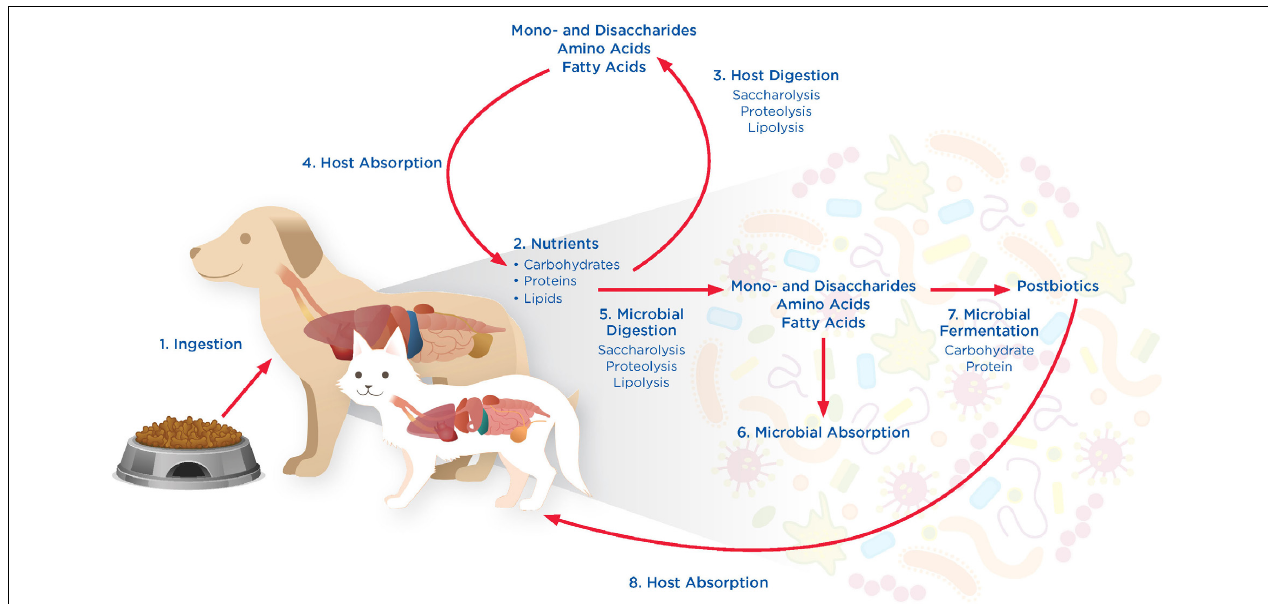
FIGURE 1 | Tripartite interactions between pet foods, the GI microbiome, and host in 8 phases. (1) Ingestion: Dogs and cats ingest nutrients such as carbohydrates, protein, and lipids, in the form of pet foods that are provided to them. (2) Nutrients: Nutrients from pet foods enter the GI tract where they are available for digestion by the host and microbiome. (3) Host Digestion: Digestion by the host involves processes such as saccharolysis, proteolysis, and lipolysis, releasing mono- and disaccharides, amino acids, and fatty acids. (4) Host Absorption: Mono- and disaccharides, amino acids, and fatty acids produced through host digestion can be absorbed and utilized by the host cells. (5) Microbial Digestion: Nutrients not digested or absorbed by the host are available for digestion by the microbiome through saccharolysis, proteolysis, and lipolysis, releasing mono- and disaccharides, amino acids, and fatty acids. (6) Microbial Absorption: Mono- and disaccharides, amino acids, and fatty acids generated through microbial digestion can be absorbed and utilized by the microbiome. (7) Microbial Fermentation: Nutrients in excess of host and microbe absorptive capabilities are bypassed to the lower GI tract where they can undergo microbial fermentation to produce postbiotics that can impact host health locally within the GI tract. (8) Host Absorption: Microbe-derived postbiotics can also be absorbed by the host, impacting host health at locations outside of the GI